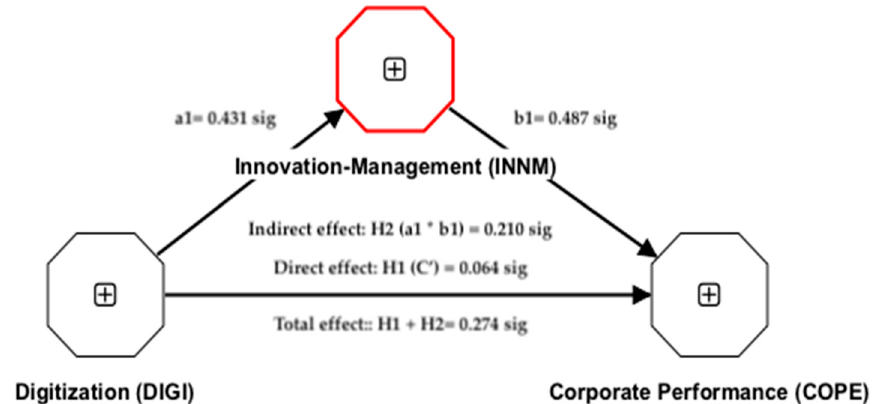
Figure 3 . Nomogram of this study (test mediation analysis). Figure 3. Nomogram of this study (test mediation